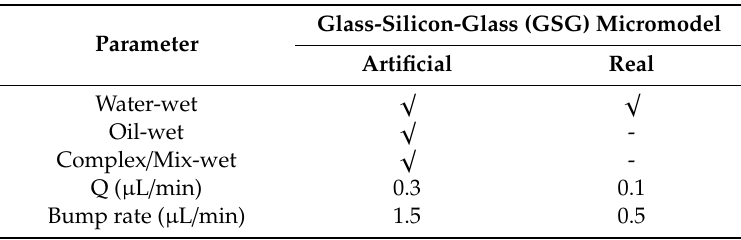
Table 4. Description of micromodels according wettability approach.